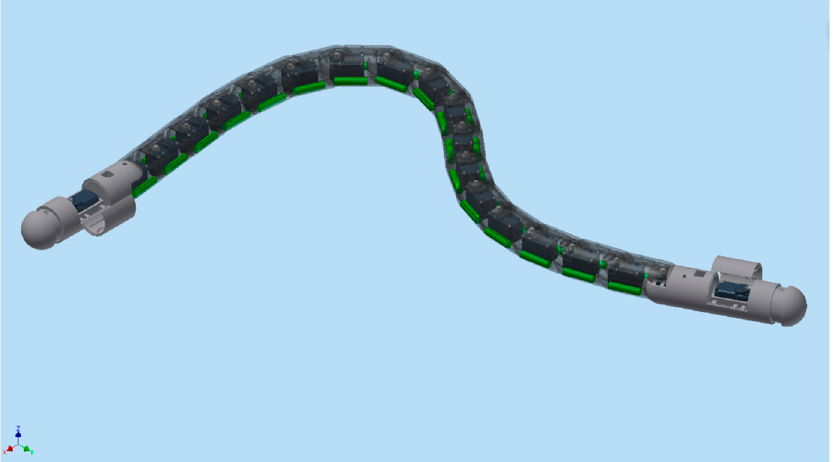
Figure 12. Rendering showing the aft tail and front head pieces with expanding and retracting assembly.